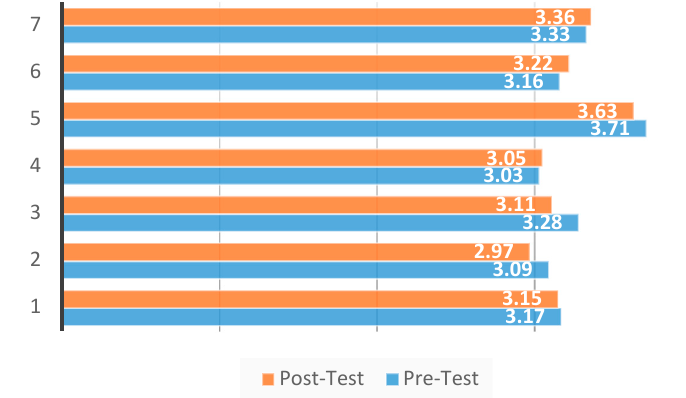
Figure 2. 4-week 20-m sprint times results ( p ≥ 0.05).